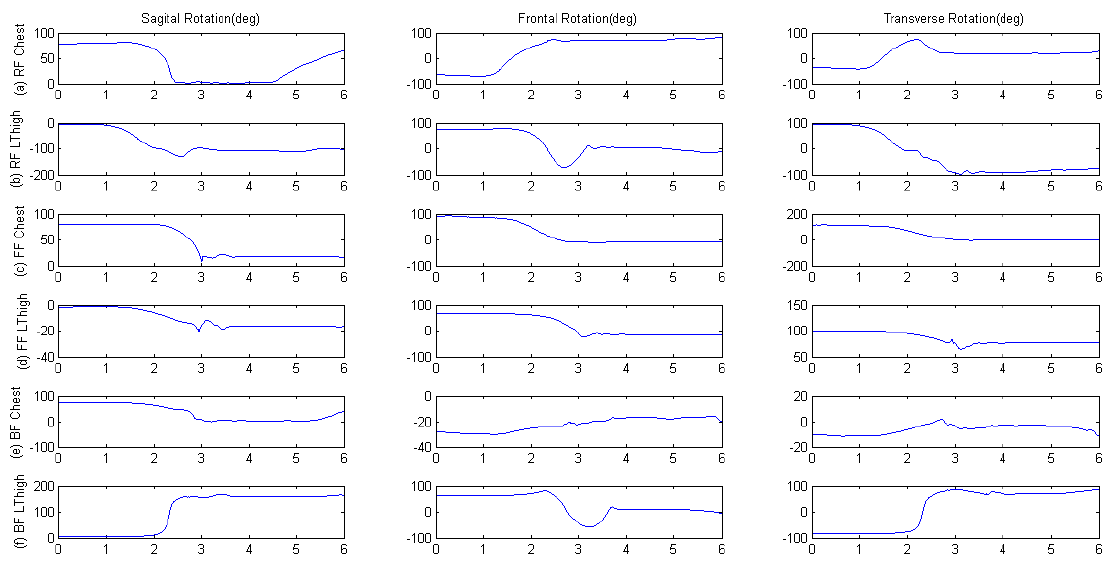
Figure 5. Orientation features of chest and left thigh during: (a,b) RF, (c,d) FF, (e,f)